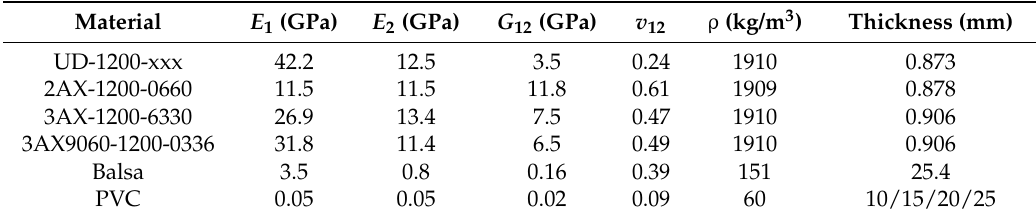
Table 2. The material properties of the blade.